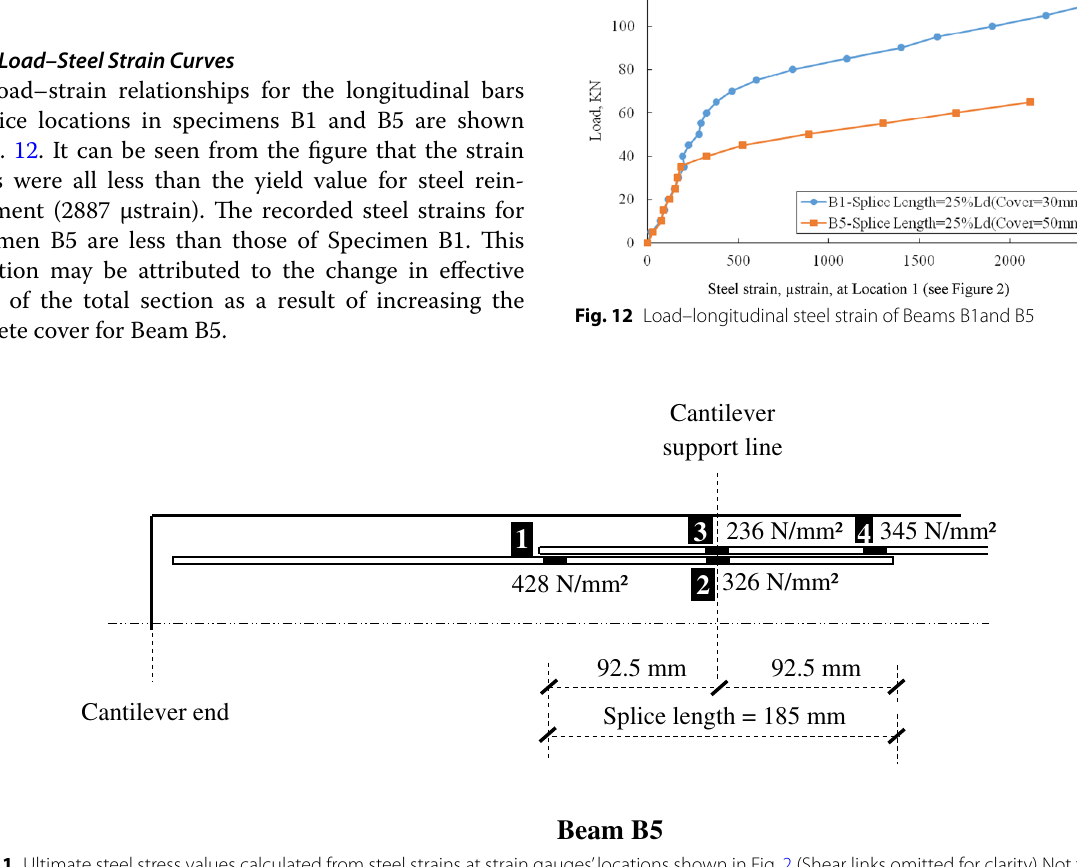
Fig. 11 Ultimate steel stress values calculated from steel strains at strain gauges’ locations shown in Fig. 2 (Shear links omitted for clarity) Not to scale